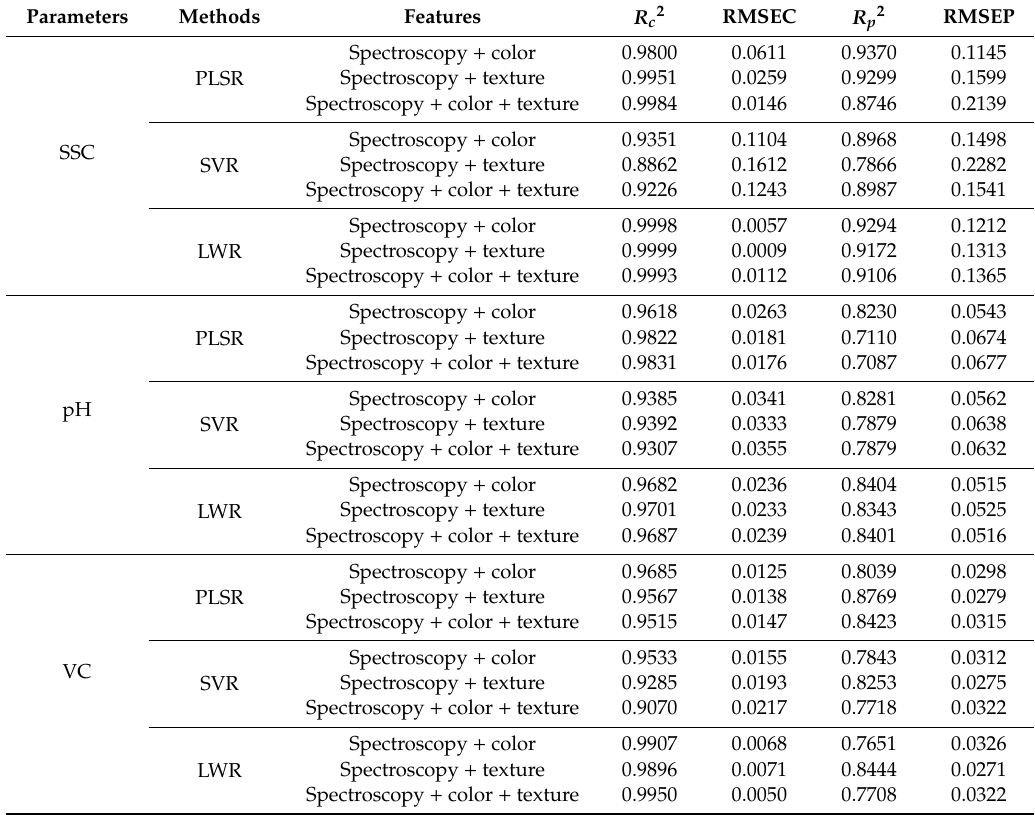
Table 3. Prediction results of SSC, pH, and VC of 120 strawberries using spectral, color, and textural features.